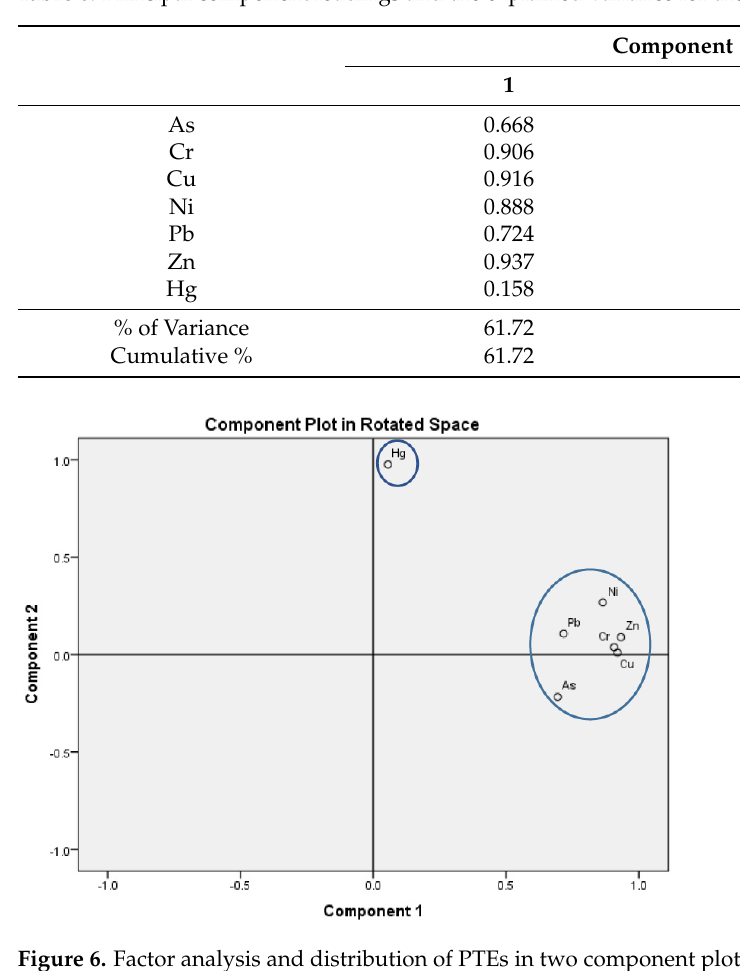
Table 6. Principal component loadings and the explained variance for the two components.